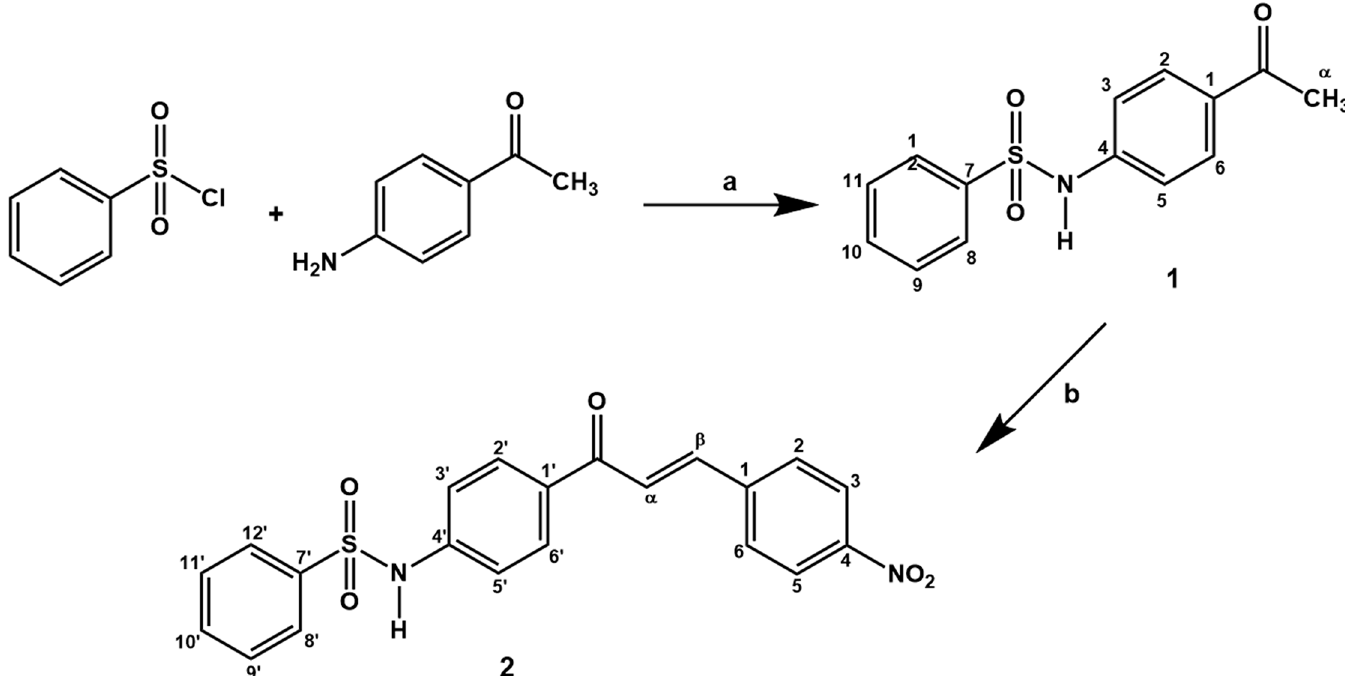
Fig 1. Synthetic route of sulfonamide chalcone (2) and its precursor, N-(4-acetylphenyl)benzenesulfonamide (1). Reagents and conditions: (a) CH 2 Cl 2 , 6 h (reflux); (b) p -nitrobenzaldehyde, EtOH, NaOH (50% w/w, ketone) 24 h (room temperature).